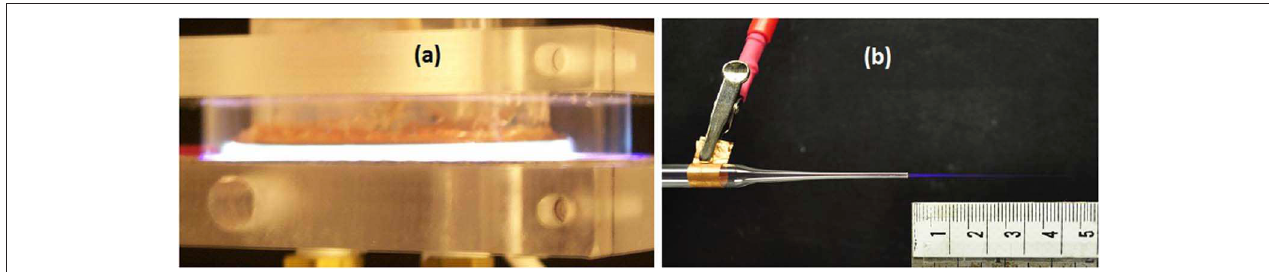
FIGURE 1 | Two sources of low temperature atmospheric pressure plasma: Dielectric Barrier Discharge in argon driven by repetitive short duration (ns - µ s) high voltage pulses (a) ; A micro-jet using helium as operating gas, generating a cold plasma plume about 2.5cm in length (b)